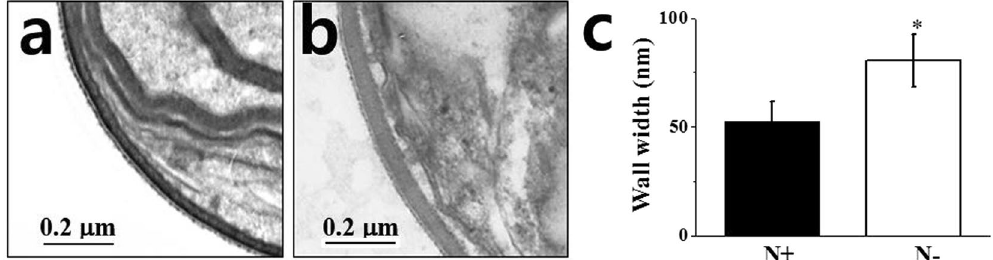
Figure 3. Representative TEM images of cell wall ( a , b ) and cell wall width ( c ) of N. salina cells grown under N + and N − conditions for 2 days. In ( c ), the cell walls of a total of 250 individual N + or N − cells were measured in five separate places.